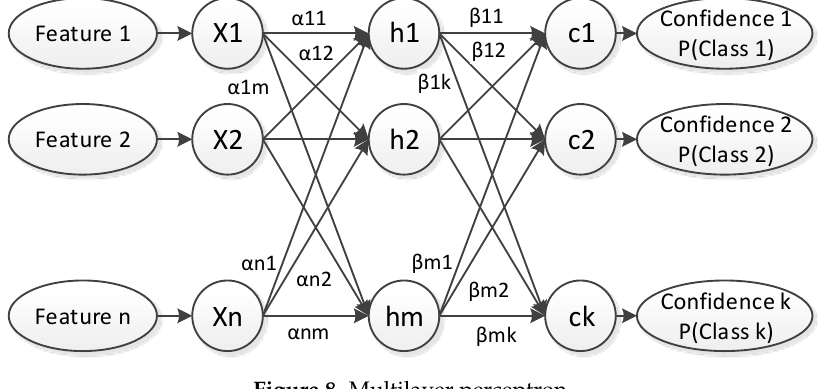
Figure 8. Multilayer